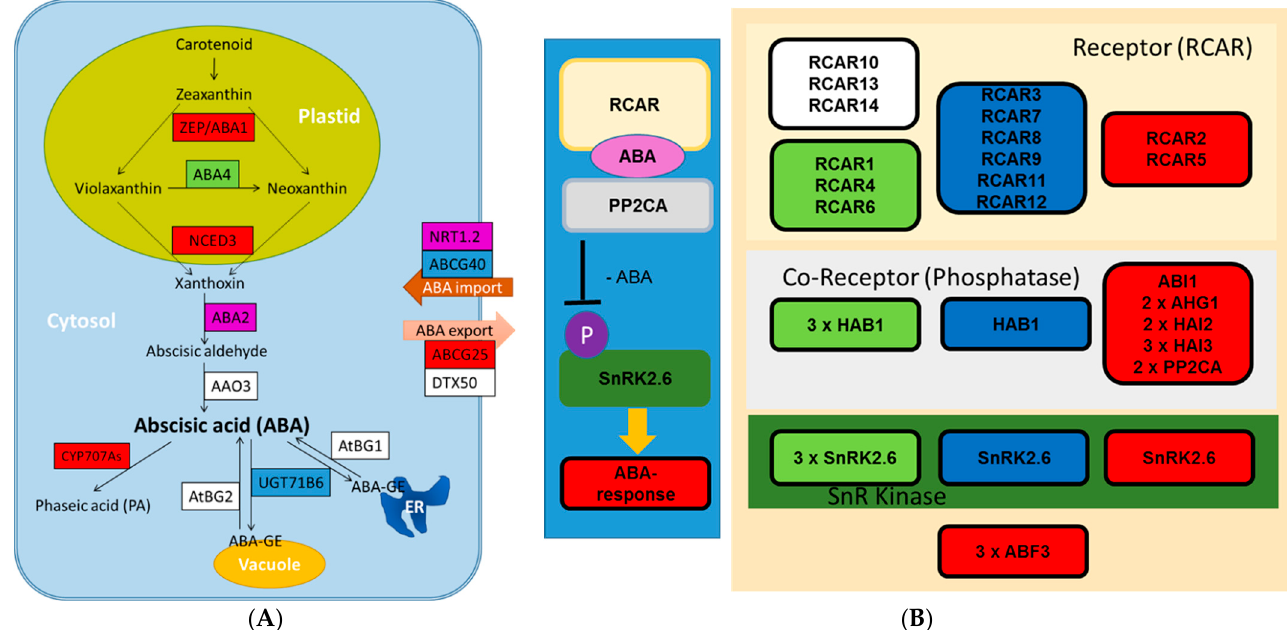
Figure 5. Transcriptional regulation of ABA metabolism ( A ) and ABA core signaling ( B ) in wood of poplar (hybrid T89) in response to severe drought stress. ( A ) Overview on ABA metabolism (modified after Chen et al. [68]) indicating drought ‐ regulated genes in poplar xylem. The data for the transcriptional responses are shown in Supplemental Table S3. Color code: White: gene not detected. Green: gene not significantly affected. Red: gene significantly up ‐ regulated. Darkblue: gene significantly down ‐ regulated. Magenta: poplar homologs show contrasting responses. Please note that poplar often contains several homologs that match one Arabidopsis thaliana locus. Abbreviations: ZEP, zeaxanthin epoxidase; NCED, 9 ‐ cis ‐ epoxycarotenoid dioxygenase; AAO, abscisic aldehyde oxidase; BG, β‐ glucosidases. ( B ) ABA core signaling involving the ABA receptors (RCARs, yellow box), ABA ‐ coreceptors (phosphatase, grey box), SnRK2.6 kinases (green box) and down ‐ stream ABA ‐ responsive transcription factors (red box). Color code for genes in the boxes is the same as in ( A ). The 14 RCAR genes in poplars were named as suggested by Papacek et al. [61]. Other genes were poplar homologs to the corresponding Arabidopsis genes.